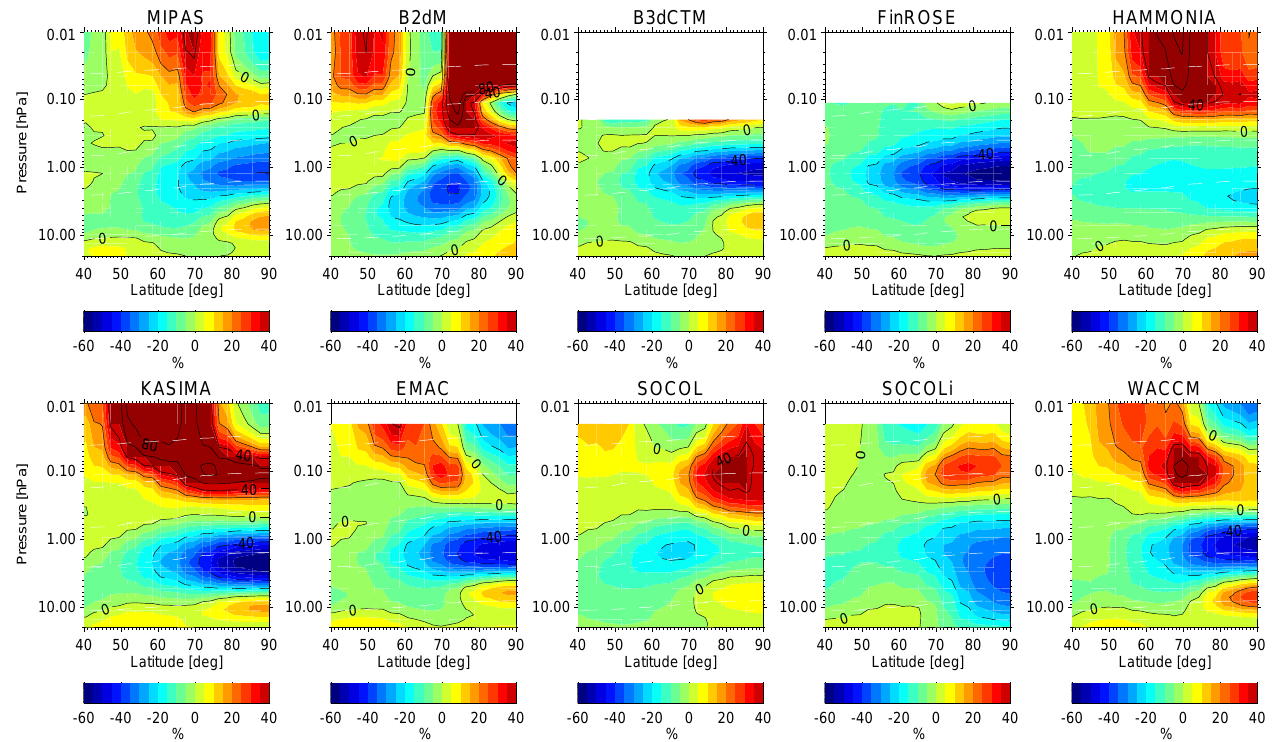
Fig. 30. Zonal mean relative O 3 changes with respect to 26 October averaged over the period 16–26 November in MIPAS observations and model simulations. Solid contour lines reflect 20% steps.